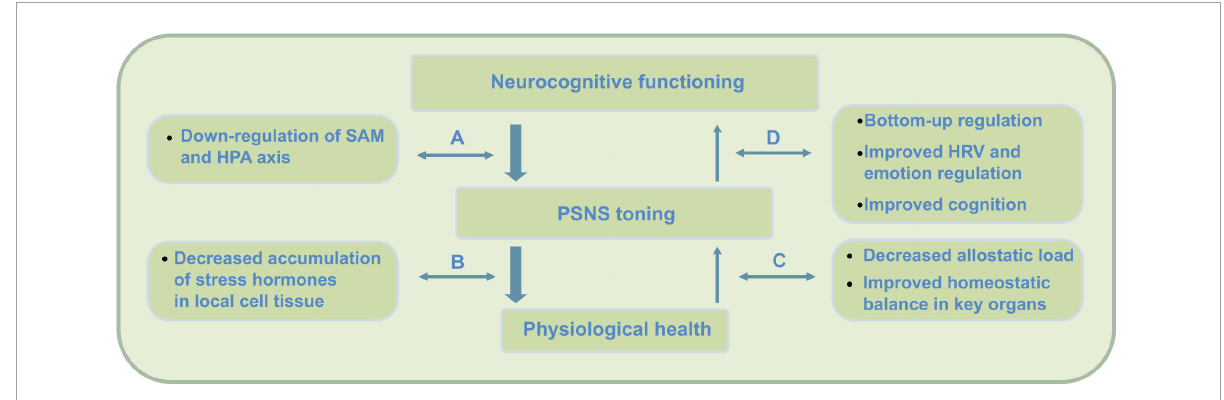
FIGURE1 Top-down (stress) regulation pathways engaged in mindfulness practice. Neurocognitive health requires the two subsystems of the autonomic nervous system (ANS) to be in balance; the ‘action or stress based’ sympathetic nervous system (SNS) and the ‘restorative’ parasympathetic nervous system (PSNS). Overactivation of the sympathetic SAM and HPA axes can cause ANS dysregulation, as the PSNS becomes less active due to accumulation of stress hormones such as cortisol. Mindfulness practice initially activates a process of top-down regulation through the inhibitory function of the PFC that causes a decrease (i.e., down-regulation) of SAM but also to a lesser extent HPA axis activation (Ochsner et al., 2009; Arnsten et al., 2015). PSNS or vagal tone, however, is strongly affected by reduced cortisol through decreased HPA axis activation – which through mindfulness may require some time to be attained. Slow reduction of cortisol through mindfulness eventually enables the ANS to extend self-regulation and somatosensory processing into awareness – which, for instance, supports mentalization processing.